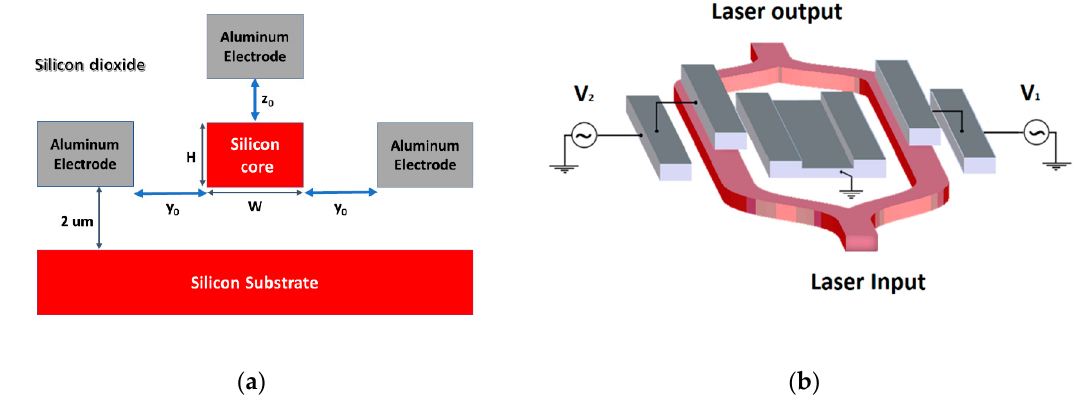
Figure 1. ( a ) A cross section of the phase shifter. The silicon core is separated from the silicon substrate by a buried oxide layer that is 2 μm thick. ( b ) Three-dimensional view of the proposed MZI